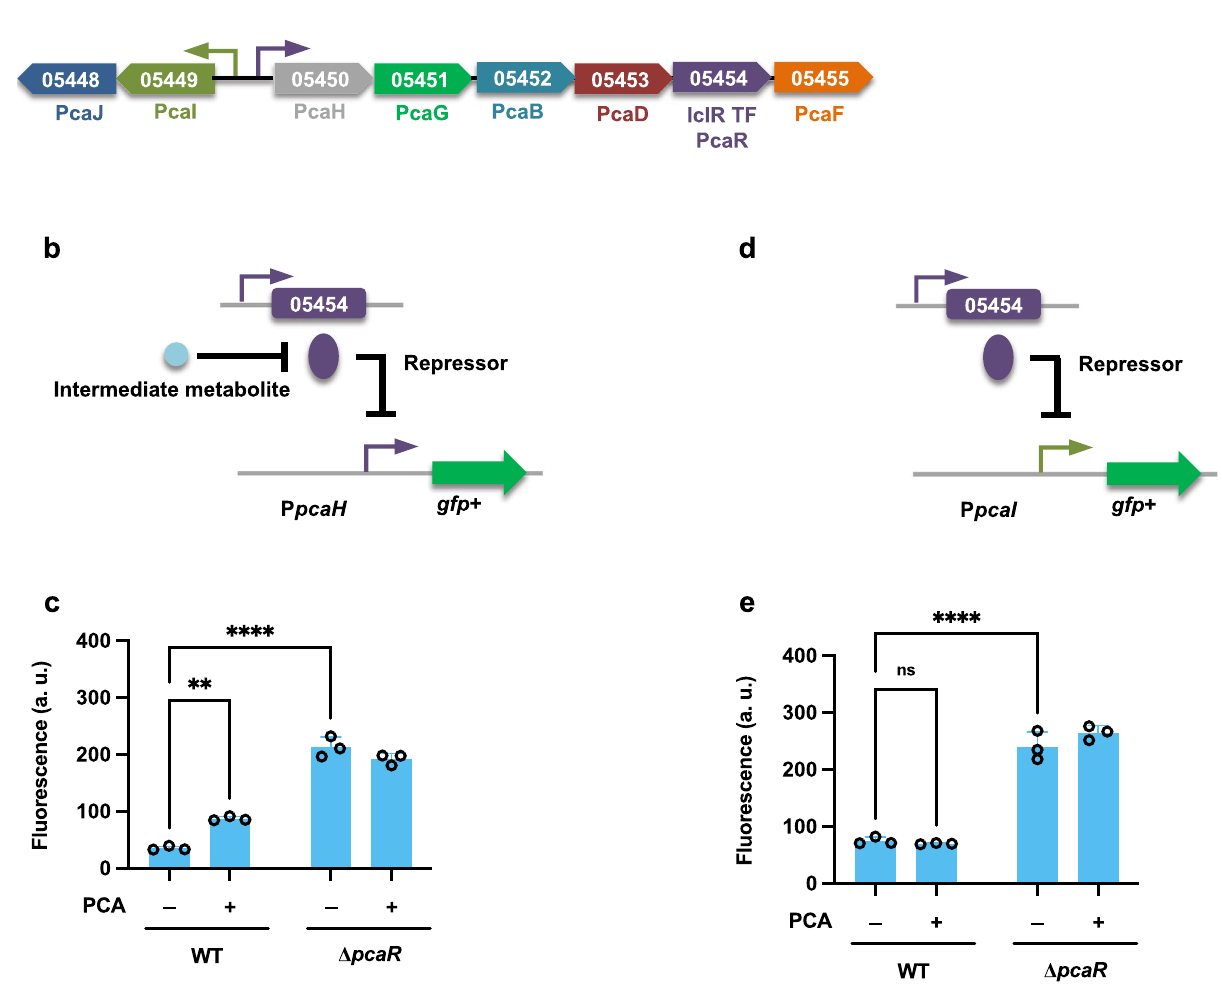
Fig. 6 Transcriptional regulation of the protocatechuic acid branch of the β -ketoadipate pathway. a A protocatechuic acid (PCA) degradation operon with an annotated transcription factor (TF). Promoters are represented as small arrows. Genes are shown with LPD gene numbers from the NCBI database (Refseq, CP003949.1). For the full annotations of the pathway genes, see Supplementary Table 1. b , d The proposed models for the role of pcaR (LPD05454). c , e To analyze the function of pcaR , the fusion construct P pcaH -GFP + and P pcaI -GFP + were expressed in both the WT and the corresponding TF deletion mutant strains. The normalized fl uorescence of the WT and Δ pcaR strains was measured with and without supplemental PCA. All cultures contained 1 g/L glucose with ( + ) or without ( − ) 0.3 g/L PCA. All the fl uorescence values were determined in the early stationary phase and normalized to OD 600 . Unpaired two-tailed t test was used to compare the variations in the changes of fl uorescence of the strains under different conditions (**, P < 0.0021; ****, P < 0.0001; ns, not signi fi cant). All values represent the mean of triplicate cultures, with error bars depicting the standard deviation from that